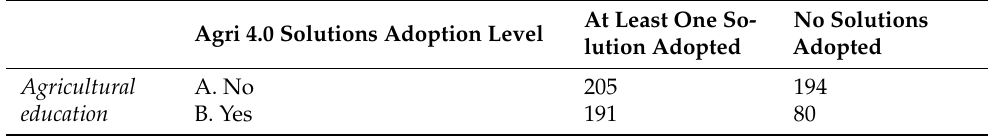
Table 11. Pearson’s χ 2 test for adoption level and type of education.